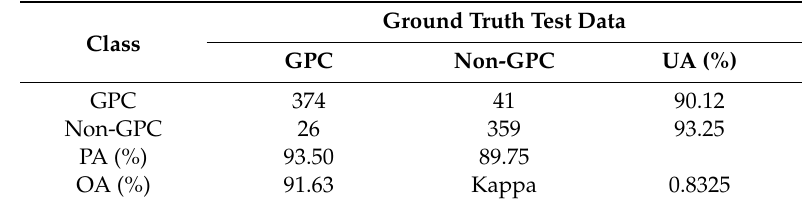
Table 2. Confusion Table 2. Confusion matrix.